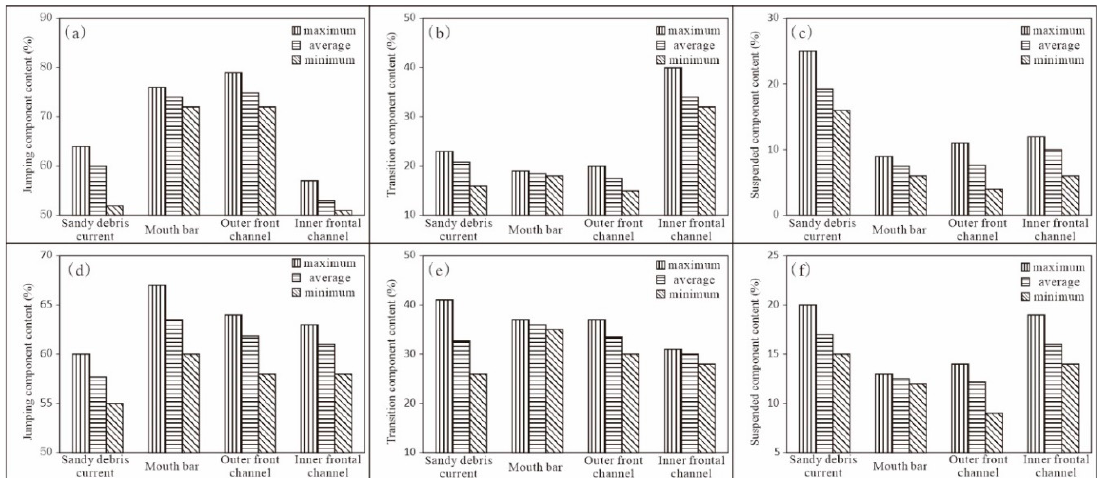
Figure 8. Comparison diagram of grain size content and slope in different sedimentary microfacies. ( a ) The bouncing component content of different sedimentary microfacies; ( b ) The transitional com- ponent content of different sedimentary microfacies (no statistics of bi-segments and tri-segments pat- terns); ( c ) The suspended component content of different sedimentary microfacies ( d ) The gradients of bouncing segment of different sedimentary microfacies (no statistics of bi-bouncing segments-one suspension segment-one transitional zone pattern); ( e ) The gradients of transitional segments of different sedimentary microfacies (no statistics of bi-segments pattern, tri-segments pattern, one bouncing segment-one suspension segment-one complex transitional zone pattern, one bouncing segment-one suspension segment-one arc transitional zone pattern); ( f ) The gradients of suspended components of different sedimentary